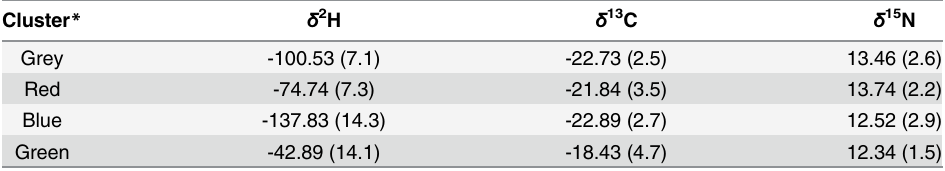
Table 2. Mean ( ± SD) stable isotope ratios of American white pelican feathers partitioned into four clusters based on k-means clustering.